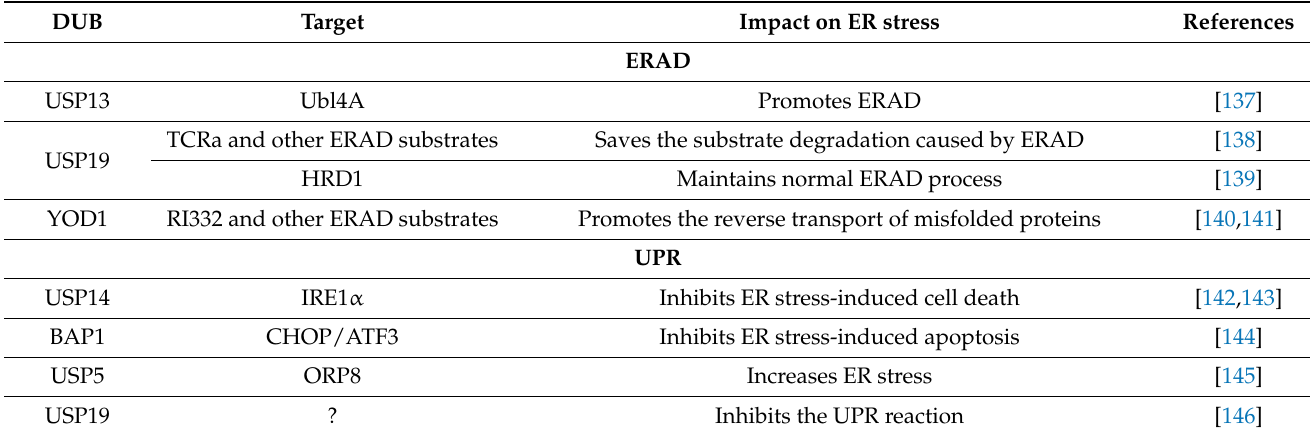
Table 2. DUBs and target proteins involved in ER